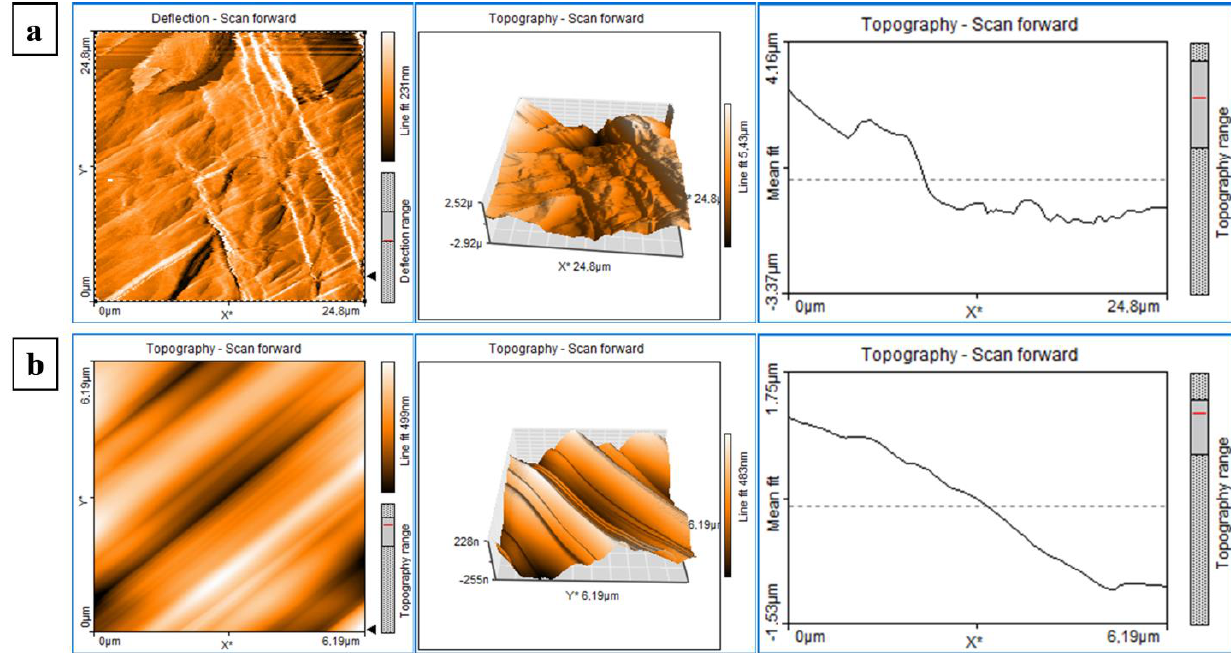
Figure 6. AFM images of the surface of the red painted layer material: ( a ) on a 25 × 25 µ m 2 ; ( b ) on 6 × 6 µ m 2 analyzed area.